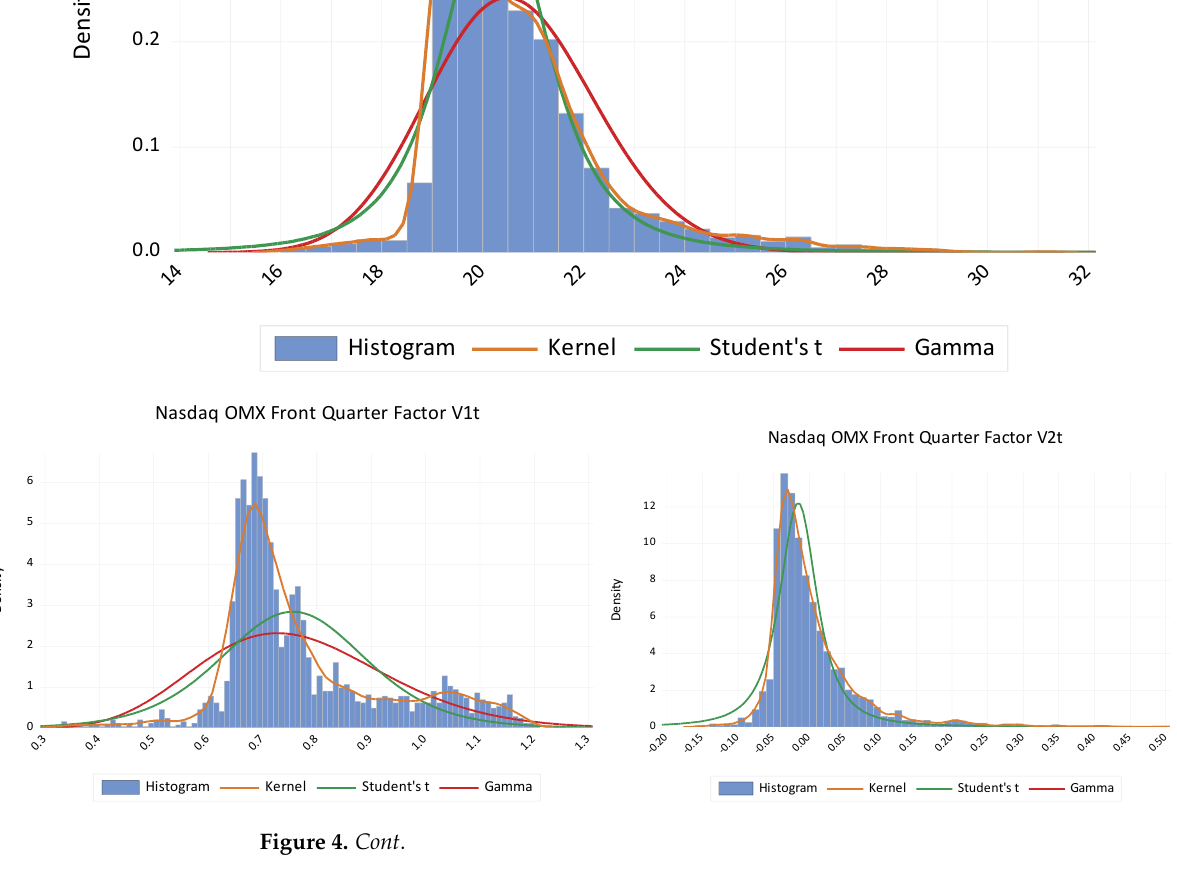
Figure 4. Stochastic Volatility Densities from Observables and the Kalman Filter. For this application of the stochastic volatility model, an estimate of * is the contemporaneous latent variable, for the purpose of pricing options for the electricity contracts. Using Black and Scholes or the Binomial Formula to price options — for example, varying contract prices and time to ma- turity — may be beneficial for market participants. Figure 5 reports a Call − Put plot over moneyness (ln(S/K)) for the front year option contracts per 1 April 2022.